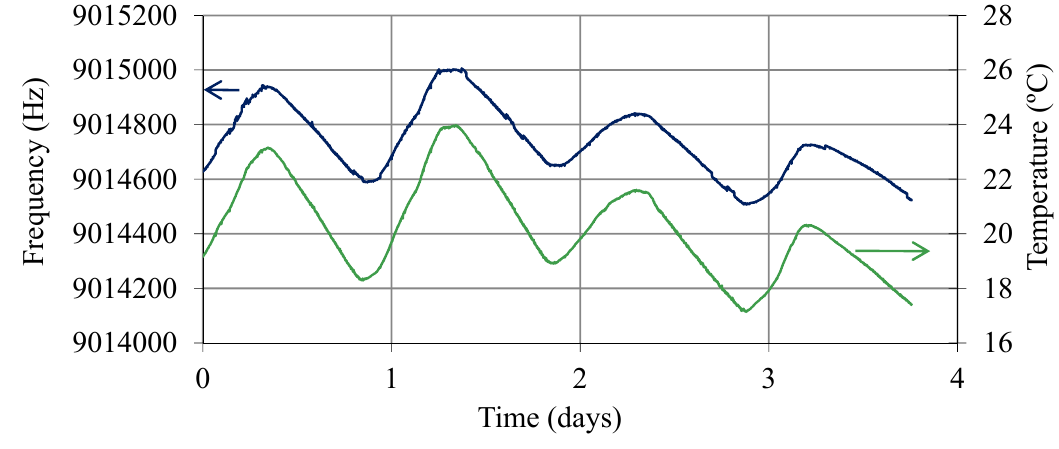
Figure 10. Oscillation frequency over four days with the resonator immersed in the battery cell of a fully charged battery (40% sulfuric acid) and temperature of the electrolyte.